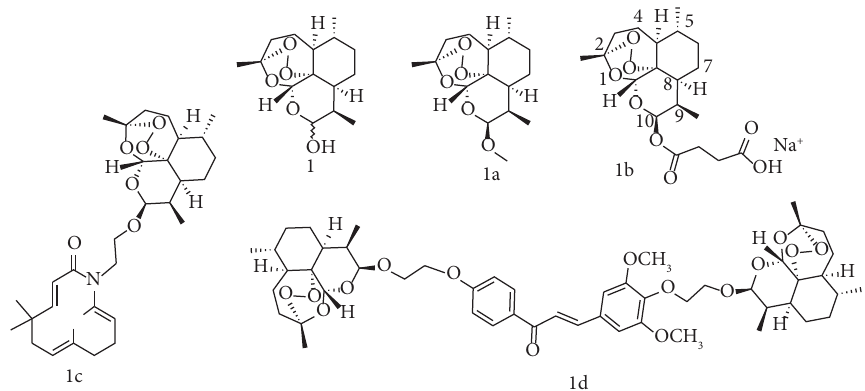
Figure 1: Typical artemisinin derivatives in clinical and pharmacological